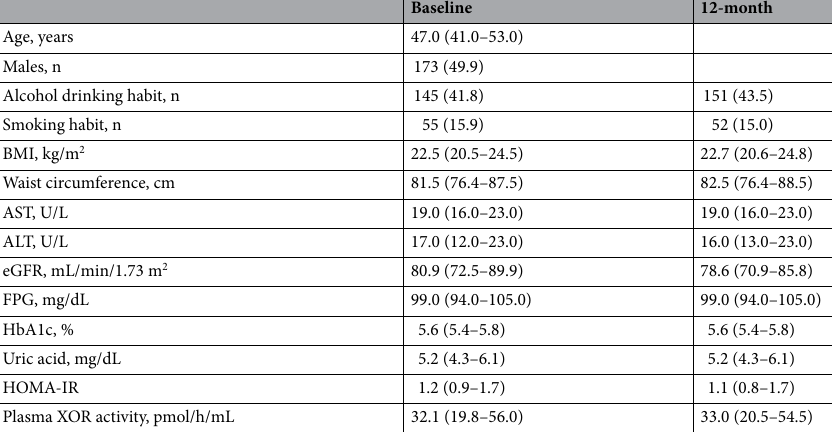
Table 1. Clinical characteristics of subjects (n = 347) at baseline and 12-month examinations. Values are expressed as median (interquartile range) or number (%). BMI body mass index, AST aspartate aminotransferase, ALT alanine aminotransferase, eGFR estimated glomerular filtration rate, FPG fasting plasma glucose, HbA1c glycated hemoglobin, HOMA-IR homeostatic model assessment of insulin resistance, XOR xanthine